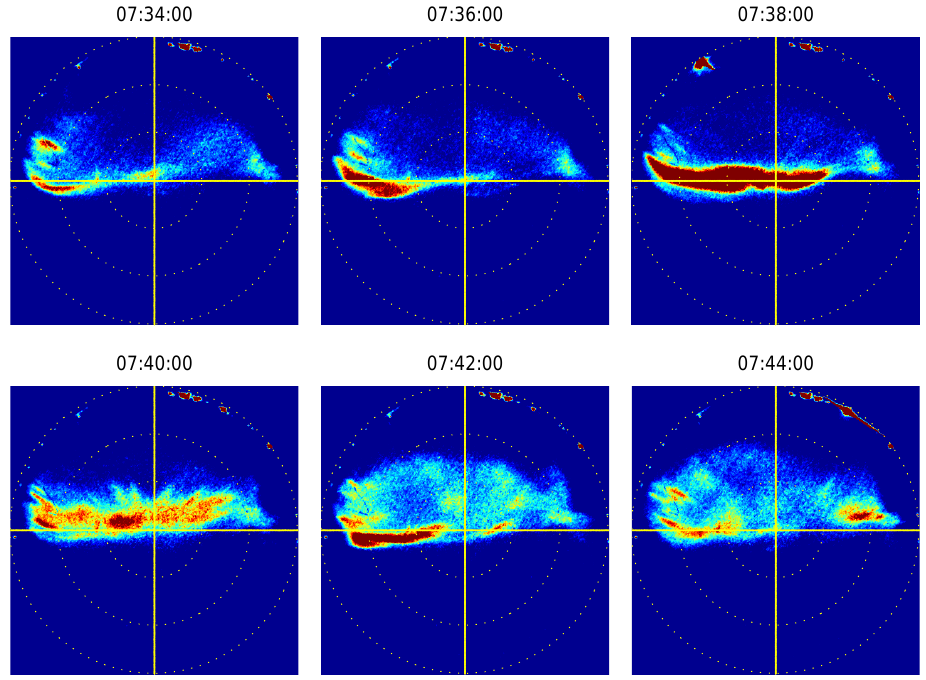
Figure 4 Fig. 4. Ny ˚Alesund ASC observations at 630.0nm during the interval 07:34–07:44 UT on 3 December 1997. The reference frame is zenith angle (dotted circles at 30, 60, and 90 ◦ ) and azimuth. The MSP scanning meridian (magnetic meridian) is marked by the vertical yellow line. North is up. West is to the left. The integration time is 2s.